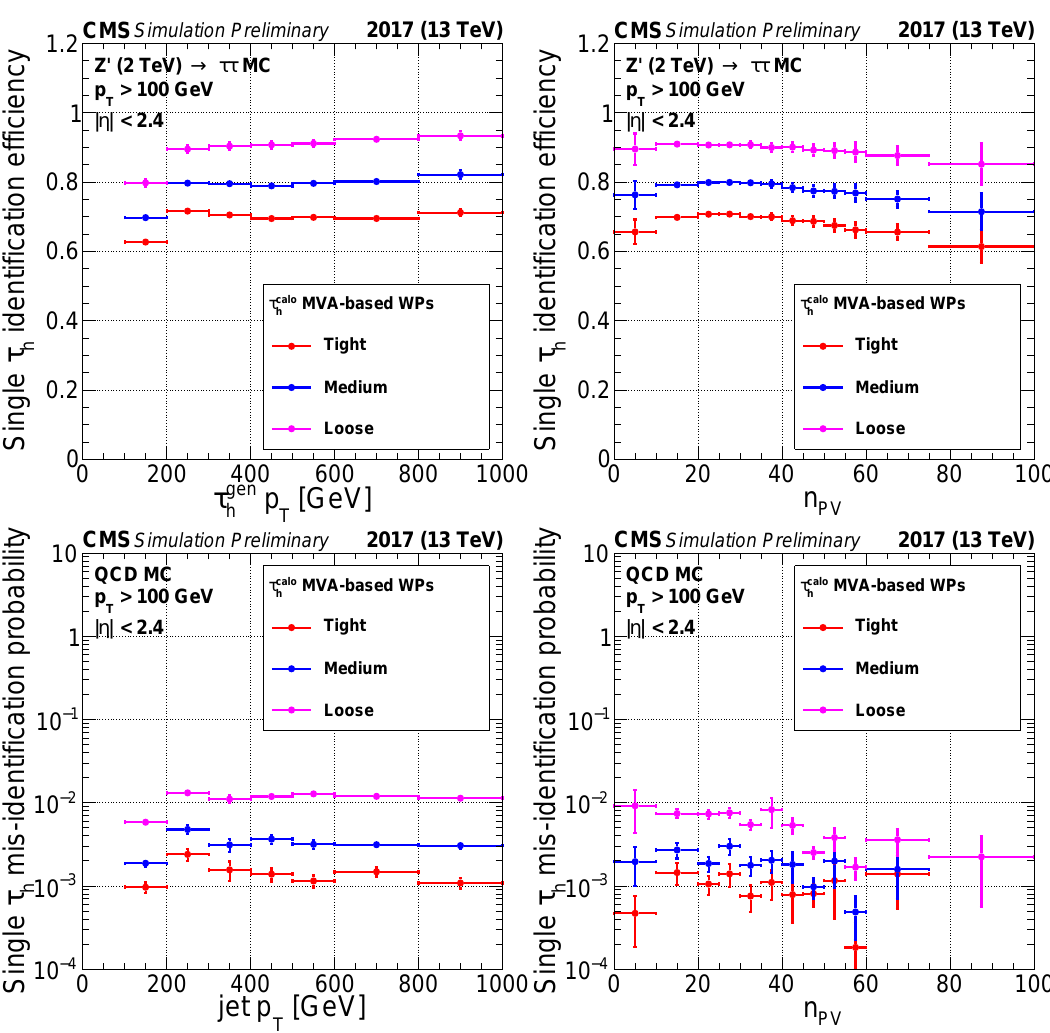
Figure 5: Left: Efficiencies (top) and misidentification probabilities (bottom) of the different MVA-based calo-tau working points as a function of generated τ Z (cid:48) ( 2 TeV ) → ττ events) and jet p left, but as a function of the number of